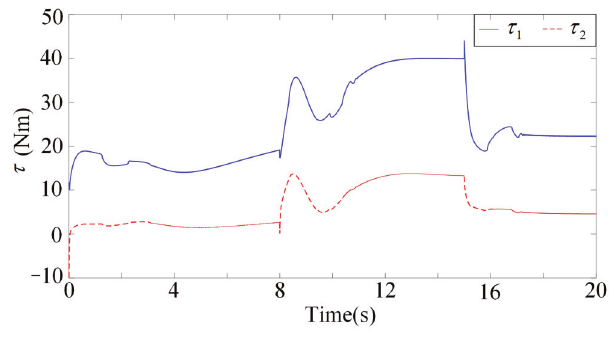
Figure 4. Simulation results of the multimodal controller in t ∈ [ 15,20 ] . ( a ) The convergence of the ˙ q to zero; ( b ) The control inputs.